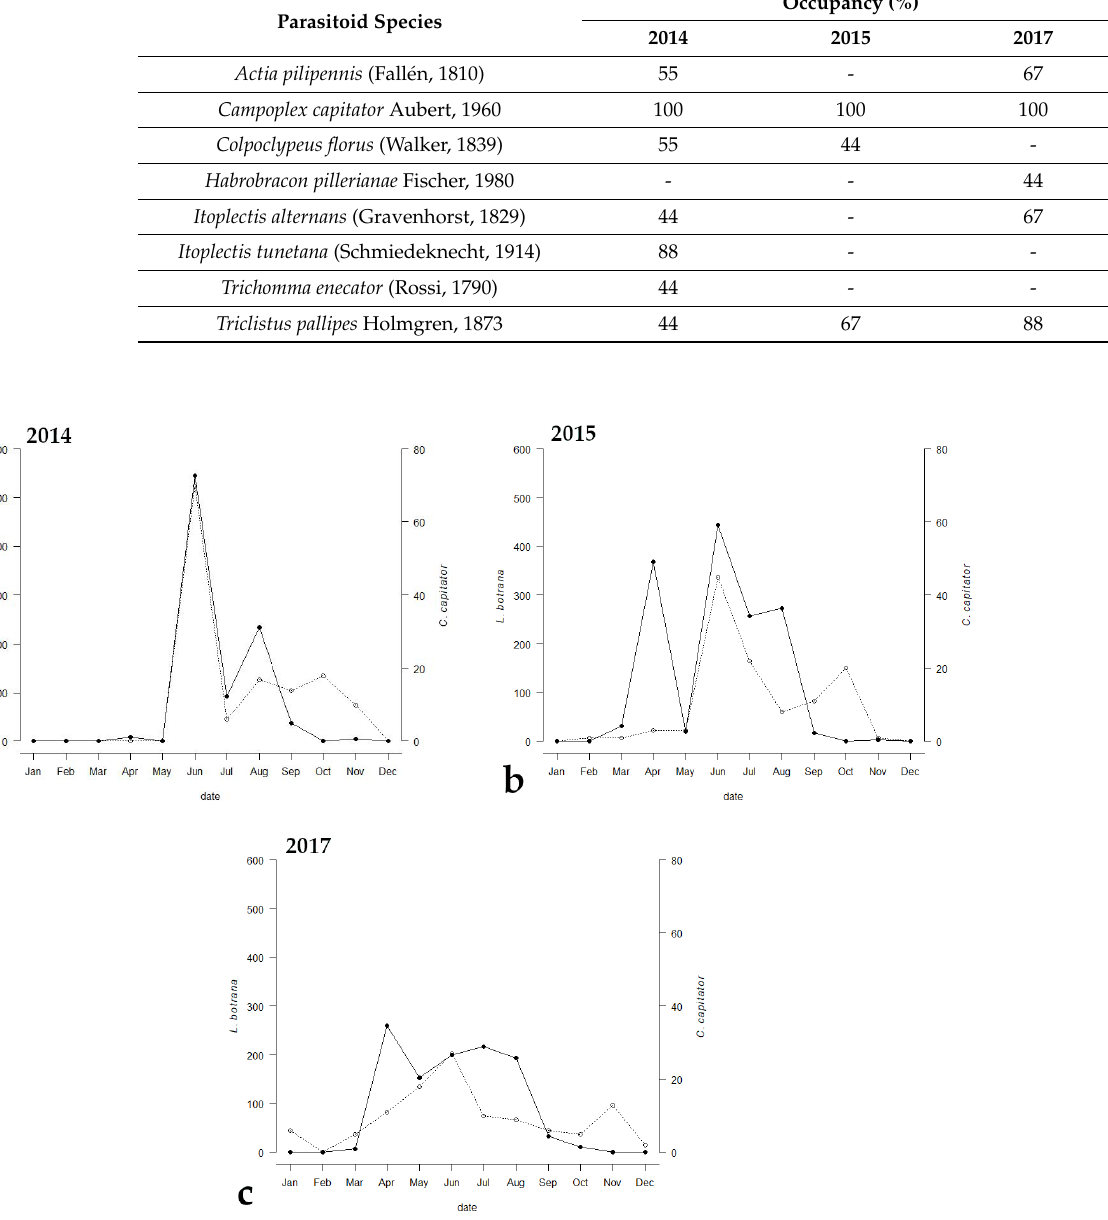
Figure 3. Emergence trends of Lobesia botrana (solid line) and its parasitoid, Campoplex capitator (dotted line), in ( a ) 2014, ( b ) 2015, and ( c ) 2017 in Tuscany, Central Italy. In 2015 the leaves and the tips of D. gnidium were also examined to assess the pres- ence of EGVM eggs. Out of 1794 EGVM eggs found on the underside of leaves of D. gnid- ium shoots, 293 were parasitized by 4 Trichogramma species: T. cordubense Vargas and Ca- bello, 1985 (58.3%), T. evanescens Westwood, 1833 (35.4%), T. euproctidis (Girault, 1911) (4.2%) and T. cacaeciae Marchal, 1927 (2.1%) (see also Lucchi et al. [63]). The overall egg parasitisation rate was 16.33%. The number of parasitized eggs varies greatly over the months ( χ 2 = 665.42; p < 0.001). The first parasitized eggs were found at the end of June, during the second EGVM flight. No parasitized eggs were found between the end of Au- gust and the beginning of September. In mid-September, there was a strong resumption of Trichogramma spp. activity, with 271 out of 475 eggs parasitized, resulting in a parasiti- sation rate of 57% (Figure 4).